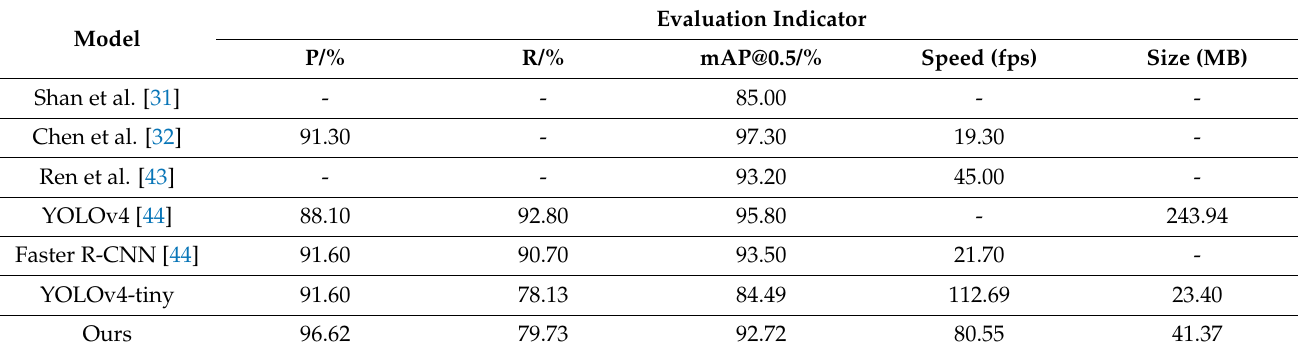
Table 5. Detection results of different networks for CCTSDB